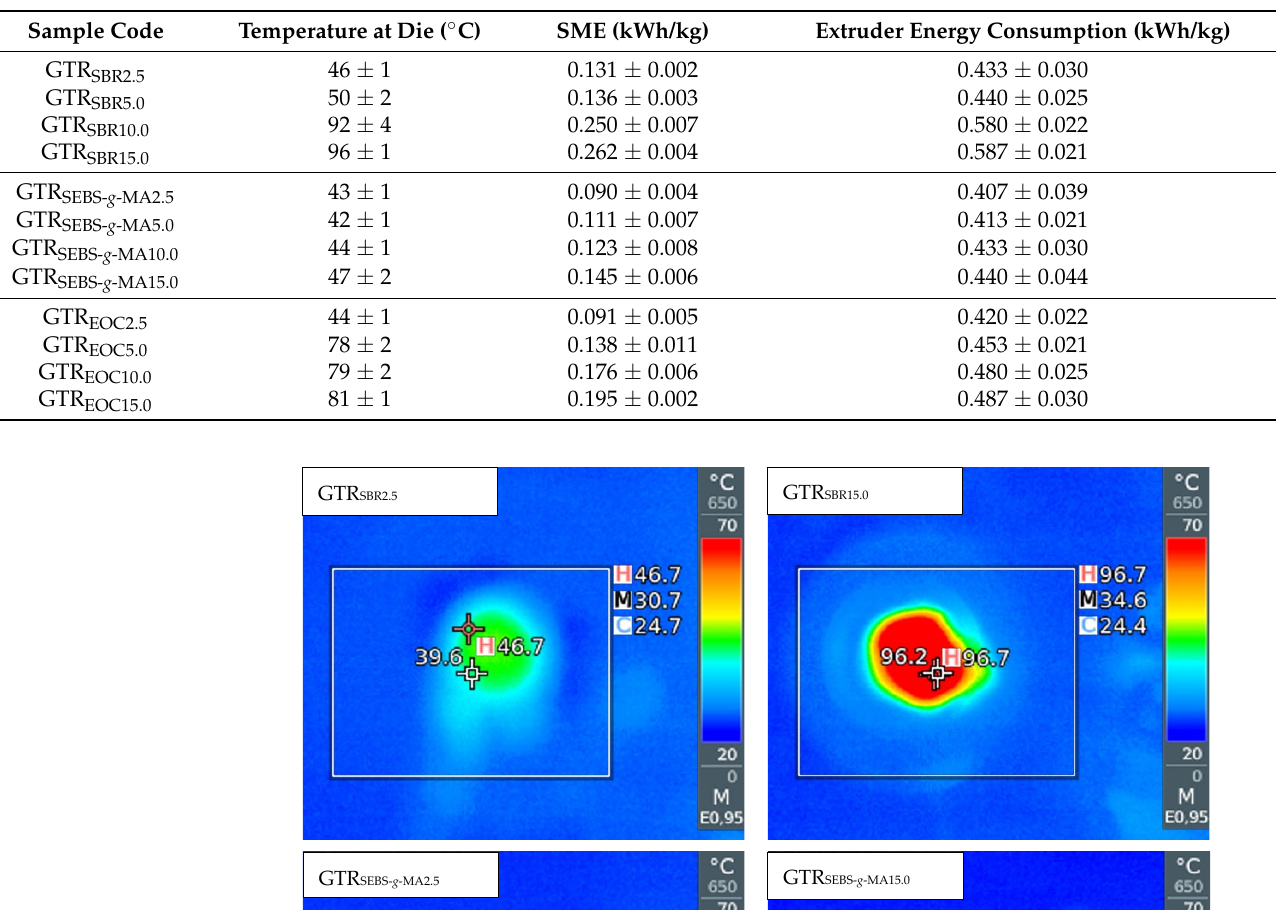
Table 2. The temperature at die and extruder energy consumption measured during GTR modification.